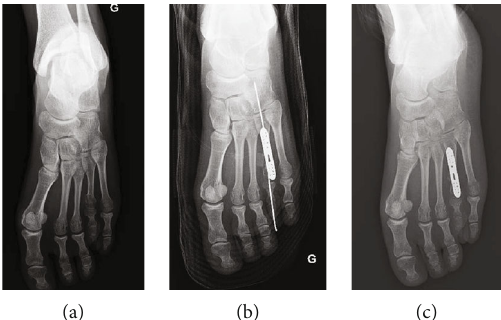
Figure 3: Case 2, a 26-year-old female with bilateral brachymetatarsia of the fourth toes who underwent surgical management of the left foot. (a) Preoperative X-ray of the left foot showing a shortness of the fourth toe of around 10mm. (b) Postoperative X-ray of the left foot. (c) Post-operative X-ray after the K-wire removal at 1-month